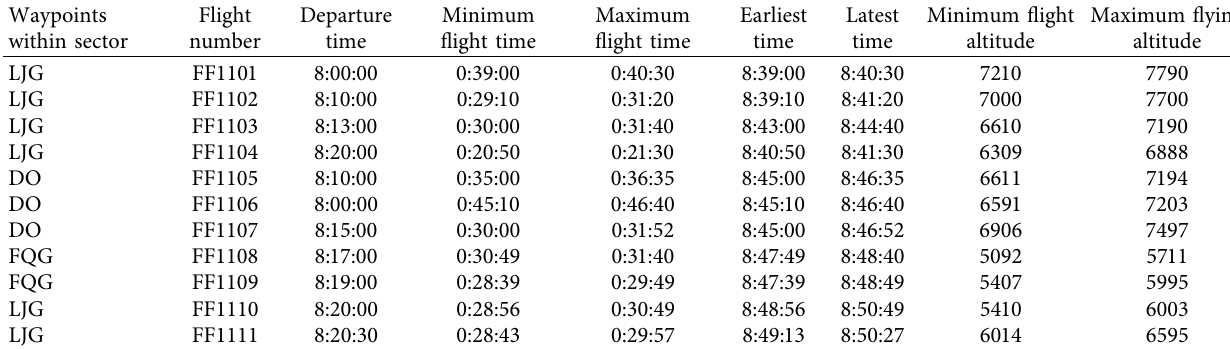
Table 1: Flight simulation data sheet.